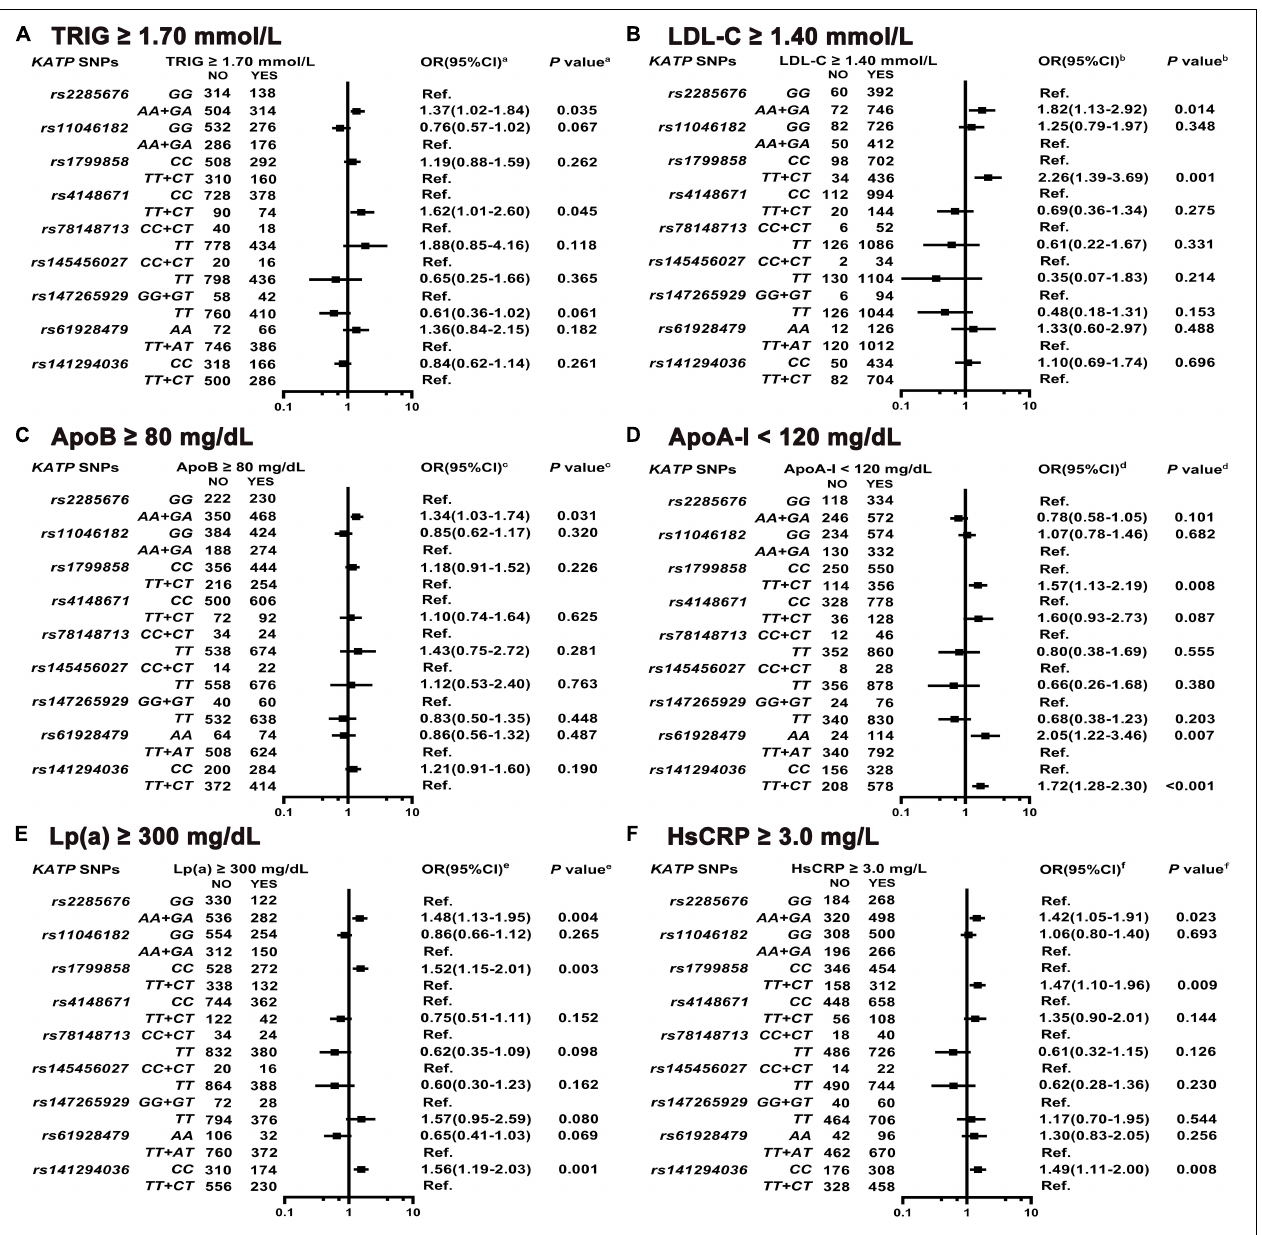
to the occurrence risk, a recent study further showed that the KATP variants (e.g., rs2237982 , rs2283261 , rs3819521 , and rs8192695 ) are also linked to the progression of vascular events, and are involved in abnormal transcription in the target-tissue and promoter/enhancer markers (41). Compared